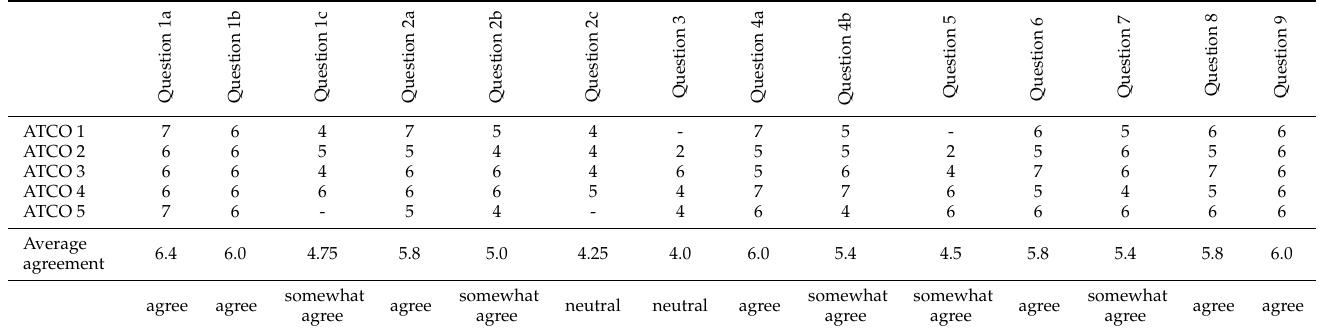
Table 2. Detailed overview of the results of the questionnaires with graded answer